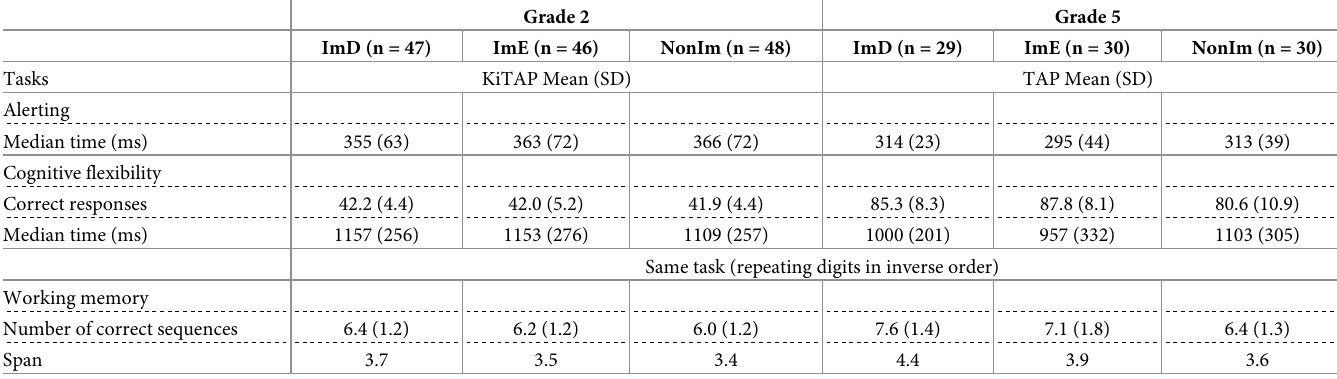
Table 4. Means (Standard deviations) of the different tasks administered, by